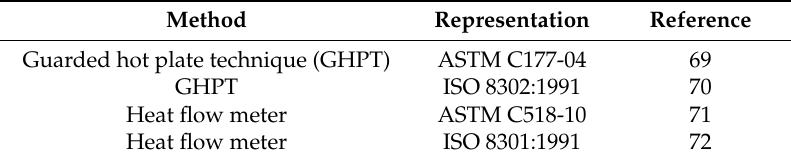
Table 7. Methods used in thermal conductivity measurement [35].